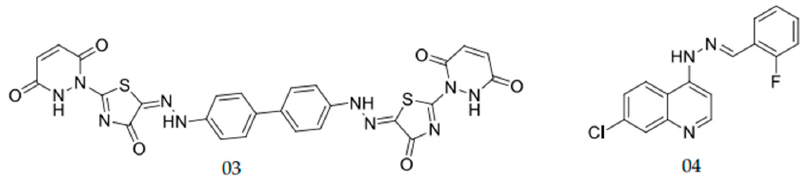
Figure 3. Aryl hydrazones which previously presented antifungal activity against Candida albicans , as published by Carvalho et al. and Abu-Melha et al. [36,37]. Hydrazone and quinone derivatives were submitted to in silico ADME/Tox prop- erty analyses. Absorption is the process whereby the drug candidate moves from the point of administration (extravascular site) to the blood (systemic circulation). The values above 90%, present an optimal intestinal profile [38]. In the present work, all tested de- rivatives revealed good theoretical absorption in the intestine, similarly to itraconazole. Moreover, some quinone derivatives and itraconazole presented permeability to Caco-2 cells. [39]. The Caco-2 in silico assay is a useful feature to analyze the passive absorption in the intestine, so the hydrophobic parameters shows the most relevance in this rela- tionship [40]. Thus, parameters such as hydrophobic (LogP), molecular polar surface area (TPSA), molecular weight and donor/acceptor of hydrogen may influence Caco-2 results. Therefore, due to the hydrophilic profile of the quinolone derivatives such as Q4, Q5 and Q11 and of the hydrazone derivatives (H1–H3), these did not show permeability profiles to the in silico Caco-2 assay. One last absorption parameter was analyzed by employing the P-glycoprotein transporters’ substrate or inhibitor [41]. The non-linear absorption kinetics of P-glycoprotein substrates has been reported due to the saturation transporter-mediated efflux activity, promoting the inhibition of intestinal P-glycoprotein resulting in signifi- cant effects of drug interaction (DDI) [42,43]. The results suggested that Q1, Q7, H2 and H3 derivative compounds were not P-glycoprotein substrates suggesting a good in silico oral bioavailability for all analyzed derivatives to be further explored. The volume of distribution (VDss), fraction unbound (human) and blood–brain barrier membrane (BBB) permeability were also analyzed, as a distribution parameter for all the studied compounds. The VDss indicates the theoretical volume that a total dose would need to be uniformly distributed in the plasma to obtain the same concen- tration observed in blood plasma. All compounds showed lower values of VDss, sug- gesting that all these prototypes need low concentrations to remain in blood plasma. A fraction of the unbound drug of all hydrazones is higher than that of itraconazole. These results indicate that these groups of molecules have a good predictive distribution be- cause the unbound form of the drug is responsible for exercising pharmacological activ- ity [44]. The blood–brain barrier (BBB) was analyzed and according to the SwissADME calculation, only the H3 derivative could pass through the blood–brain barrier.